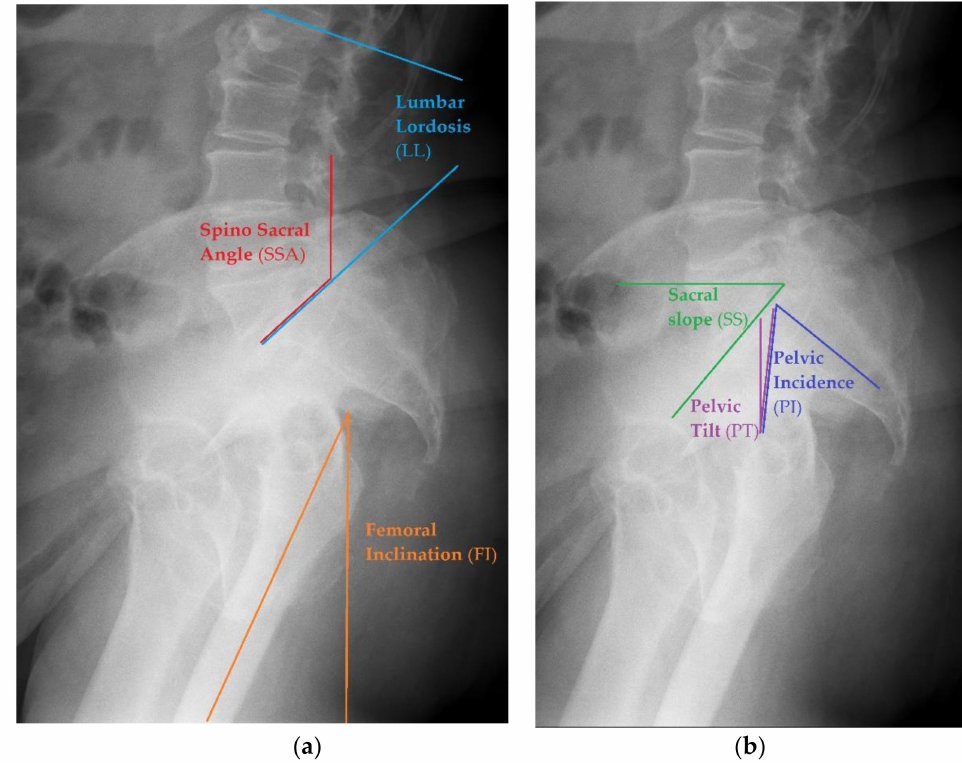
Figure 1. Examples of different pelvic measurements performed on lateral X-rays of the pelvis with lumbar spine view. ( a ) Spino Sacral Angle, Lumbar Lordosis and femoral Inclination presented on lateral X-ray. ( b ) Sacral Slope, Pelvic Incidence and Pelvic Tilt presented on lateral X-ray. Radiographic